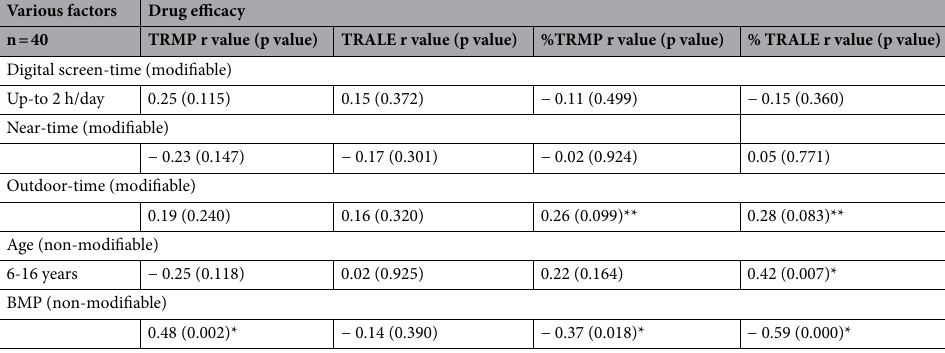
Table 4. Correlation of drug efficacy (TRMP, TRALE, %TRMP, %TRALE) with various modifiable and non-modifiable factors. *p value of statistical significance < 0.05; **p value showing trend for significance though not statistically significant. TRMP True reduction in Myopia progression in treatment eyes compared to control; TRALE True reduction in Axial length elongation treatment eyes compared to control, %TRMP percentage TRMP, %TRALE percentage TRALE.